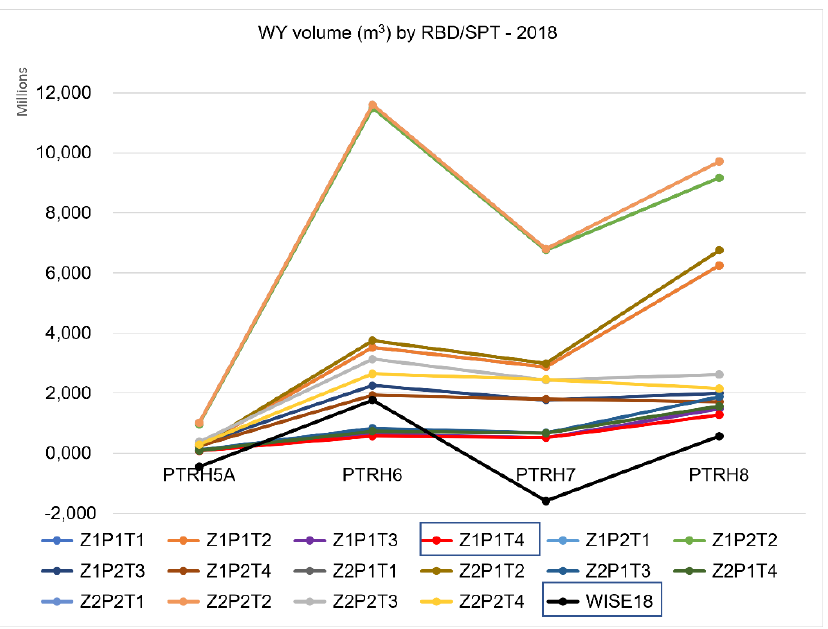
Figure 13. Estimated WY volume (m 3 ) in 2018 by RBD/SPT sector and observed values. After calibrating the model by sectors with the best simulation performance in 2018, the mean volume of the estimated water yield by RBD was compared with the freshwater resources availability volume, published by [29]. Results at the national level show a correlation coefficient of 0.803 with statistical significance for 0.01 one-tail. Table 4 has the values used to estimate model’s accuracy. Table 4. Mean estimated WY, observed values and the error in the estimations.